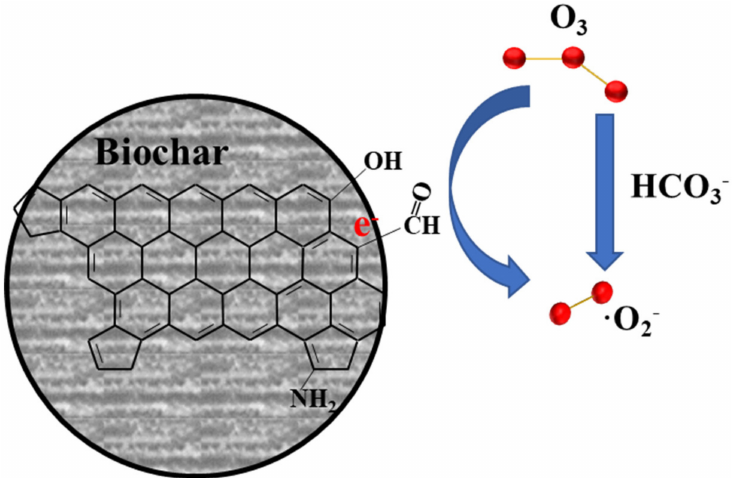
Figure 6. Mechanism of ozonation catalyzed by biochar [21].